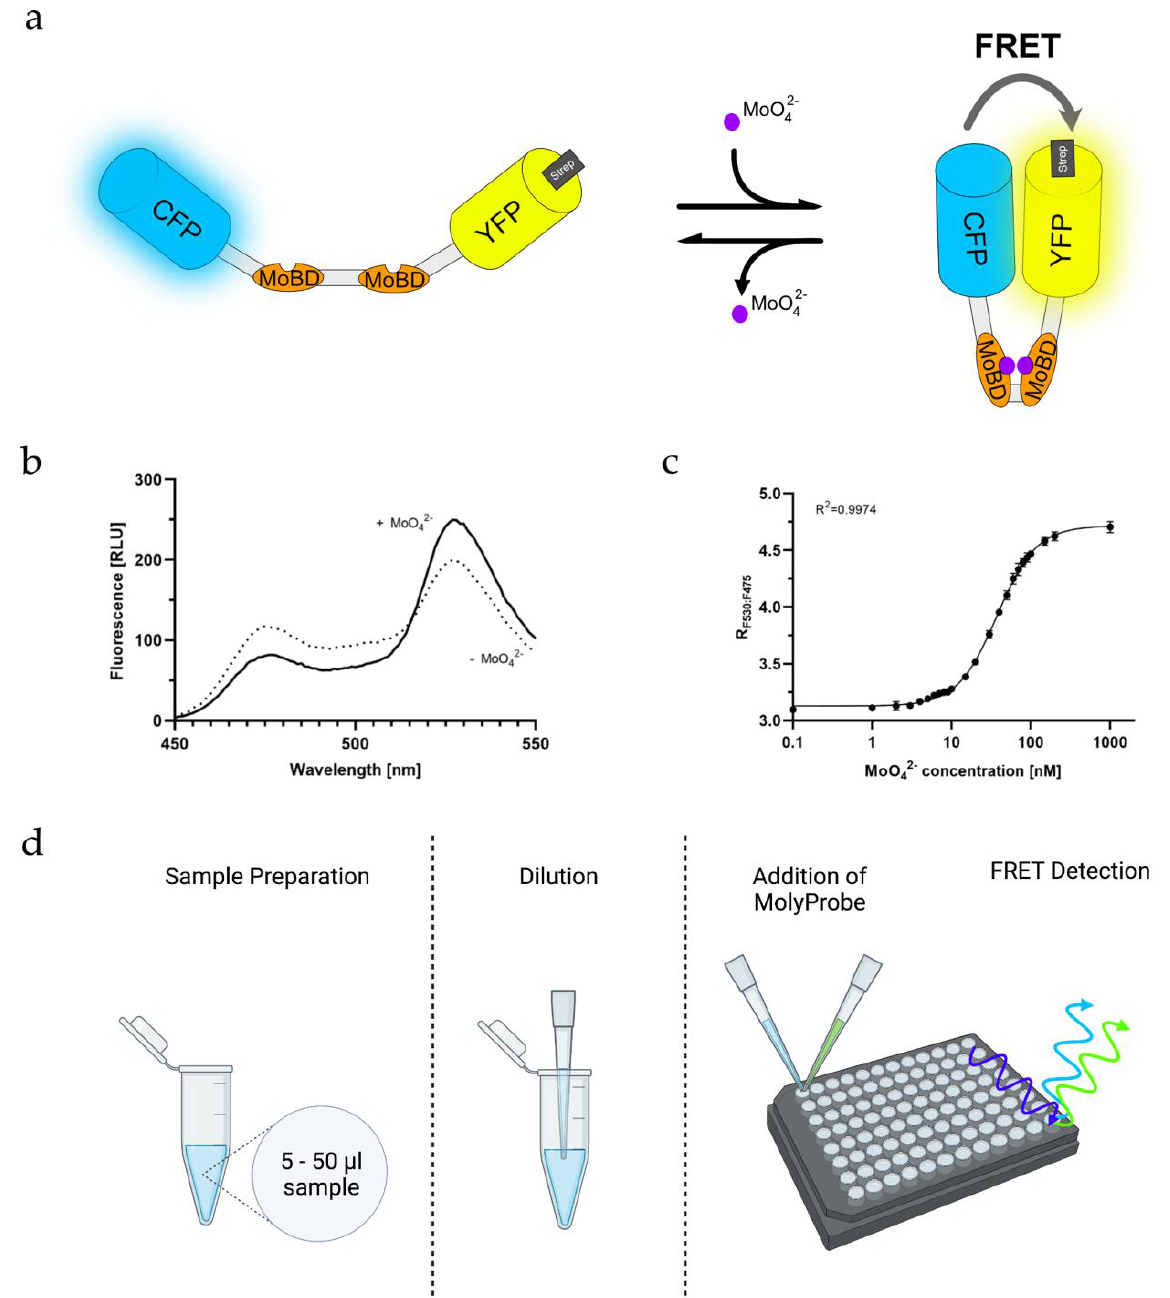
Figure 2. In-vitro-based molybdate detection assay: ( a ) Schematic representation of the MolyProbe- Strep reaction with molybdate, binding two molybdate ions per molecule; ( b ) Emission spectrum of the MolyProbe with (+) and without ( − ) 10 µ M molybdate; ( c ) Large-scale measurement with 20 data points from 0.5 nM to 1 µ M molybdate. The emission spectrum (450–550 nm) was measured at room temperature. An amount of 20 nM MolyProbe was used in reaction volumes of 500 µ L ( n = 3); ( d ) Preparation of a MolyProbe assay displayed, 5–50 µ L sample was transferred into a new tube and diluted to 50 µ L. This dilution step was repeated until an estimated molybdate concentration of 20–200 nM molybdate was reached, then 50 µ L of the MolyProbe reaction buffer containing 40–320 nM MolyProbe-Strep was added to the mix. After 5 min, FRET was